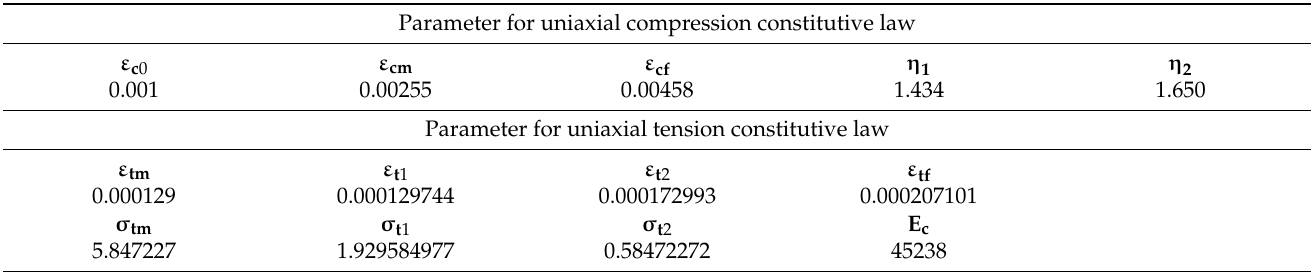
Table 7. Key parameters to determine the constitutive law of materials. Parameter for uniaxial compression constitutive